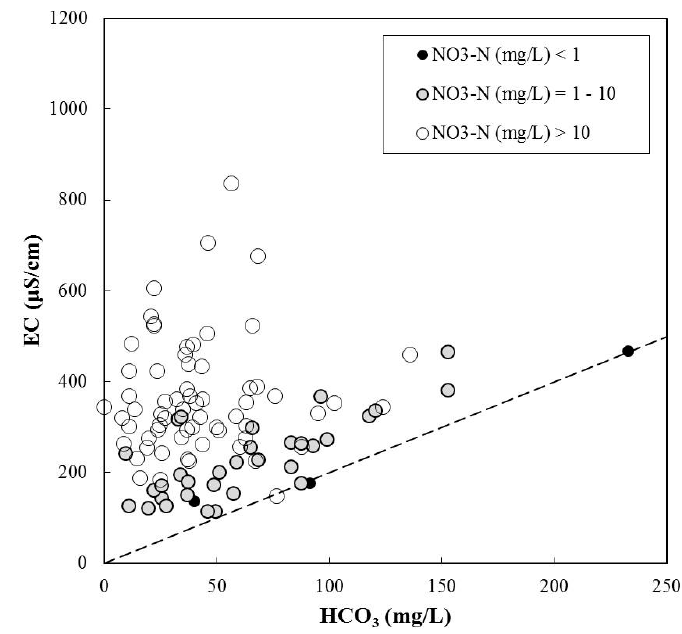
Figure 2. Effect of NO − pollution on electrical conductivity and alkalinity. The dashed line indicates concentrations due to natural processes of weathering. A sample whose EC was 1776 µ S/cm was excluded from the figure.